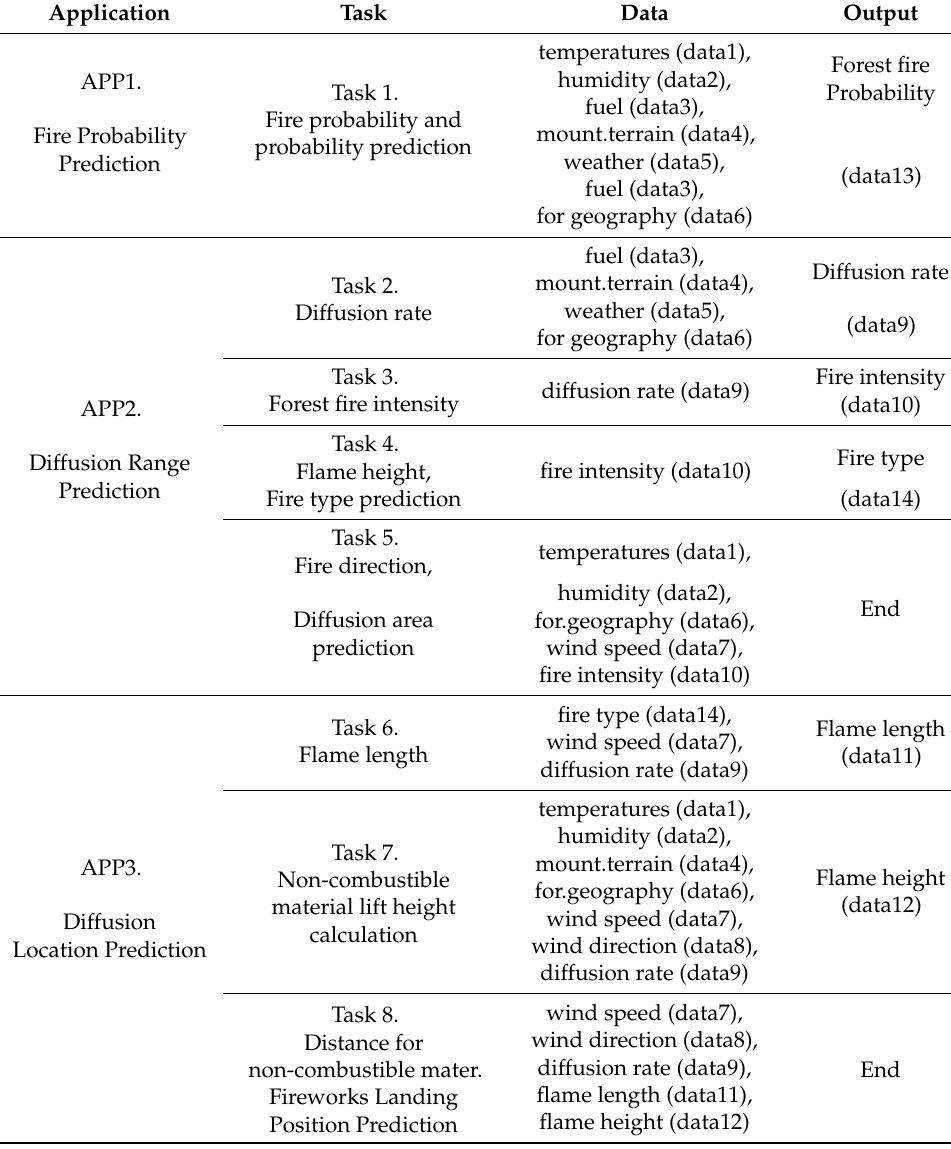
Table 1. Tasks for forest fire response and data types